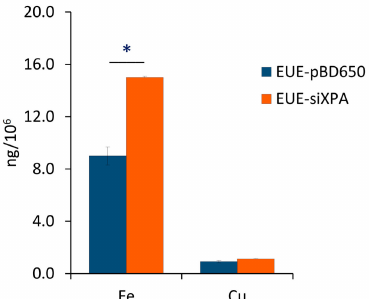
Figure 5. Iron and copper levels in XPA-defective cells and in their normal counterpart, quantified by